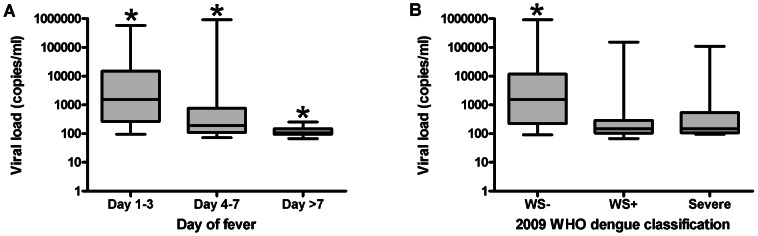
Viral load.A: Day of fever: All three groups differed significantly from each other with the highest levels at day 1–3 and the lowest levels at day>7 (Day 1–3 vs day 4–7 P = 0,001; day 1–3 vs day>7 P<0,0001; day 4–7 vs day>7 P = 0,006). B: 2009 WHO dengue case classification: levels in WS− patients were significantly increased compared to WS+ and severe patients (WS− vs WS+ P<0,0001; WS− vs severe P = 0,001). Abbreviations: WS−: non-severe dengue without warning signs, WS+: non-severe dengue with warning signs. Horizontal bars inside the boxplot indicate the median. The box indicates the interquartile range. Black asterisk = significantly different from all other groups. The Mann-Whitney U test was used to compare the groups with each other.